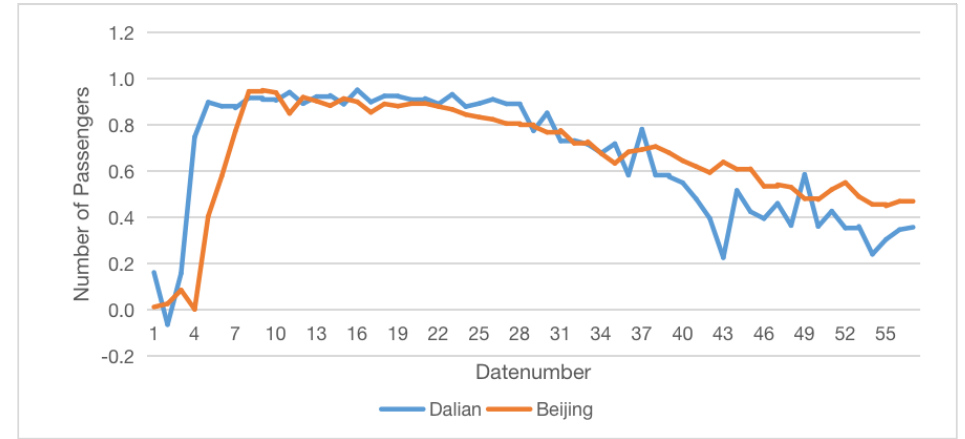
Figure 10. Relative impact of the local outbreaks in Beijing and Dalian.